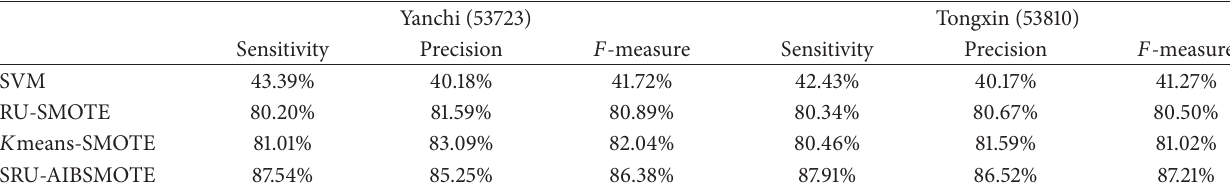
Table 5: The comparison performances of different